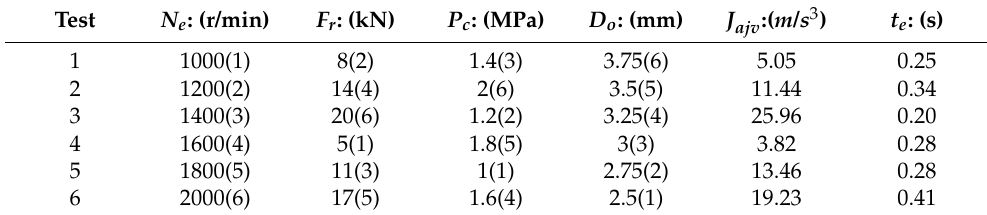
Table 5. The test results of acceptable jerk and shift